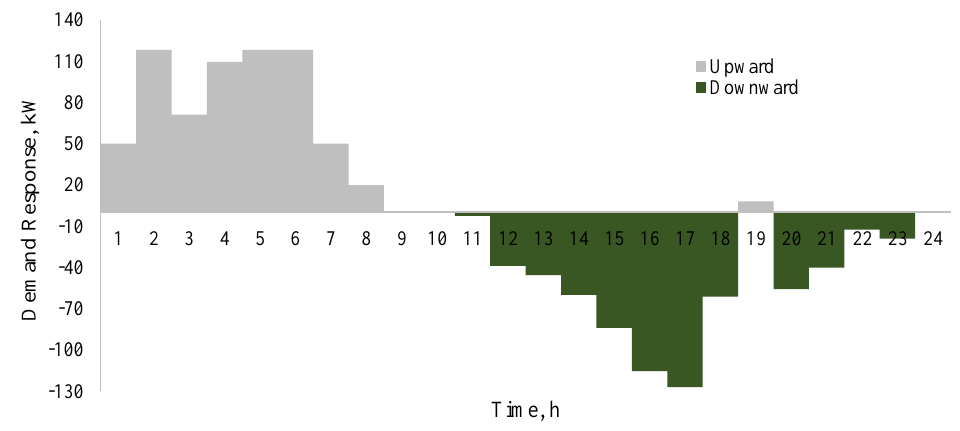
Figure 5. Demand response of the battery-swapping station.